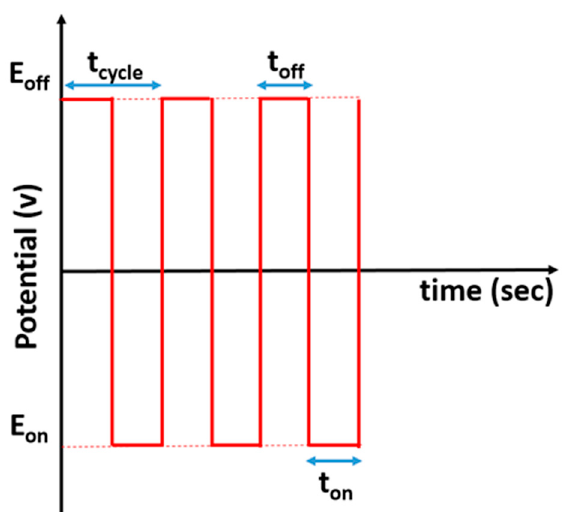
Figure 1. Schematic description of potential pulsed deposition method.